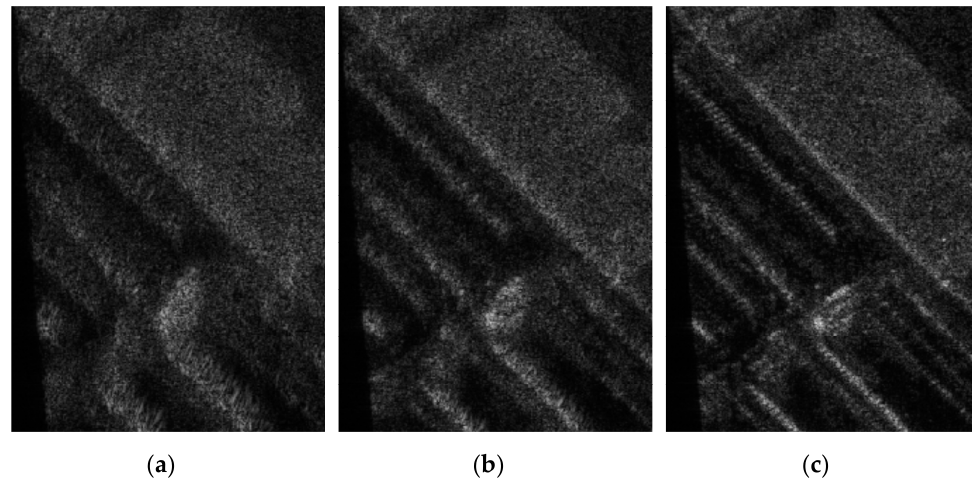
Figure 22. The enlarged view of the selected area in Figure 21 processed by the di ff erent algorithms. ( a ) The conventional method; ( b ) The reference method; and ( c ) The proposed method.